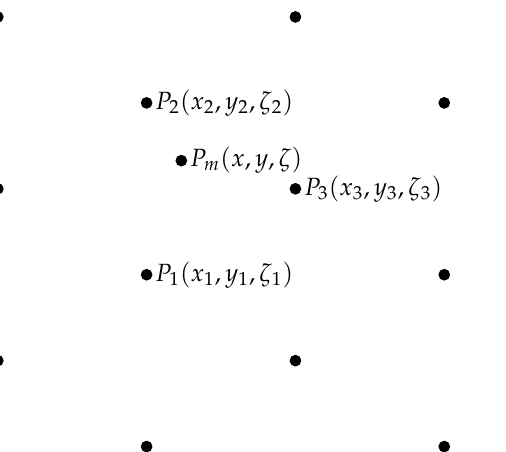
Figure 4. Point P m with continuous coordinates and its nearest integer neighbors P 1 , P 2 , P 3